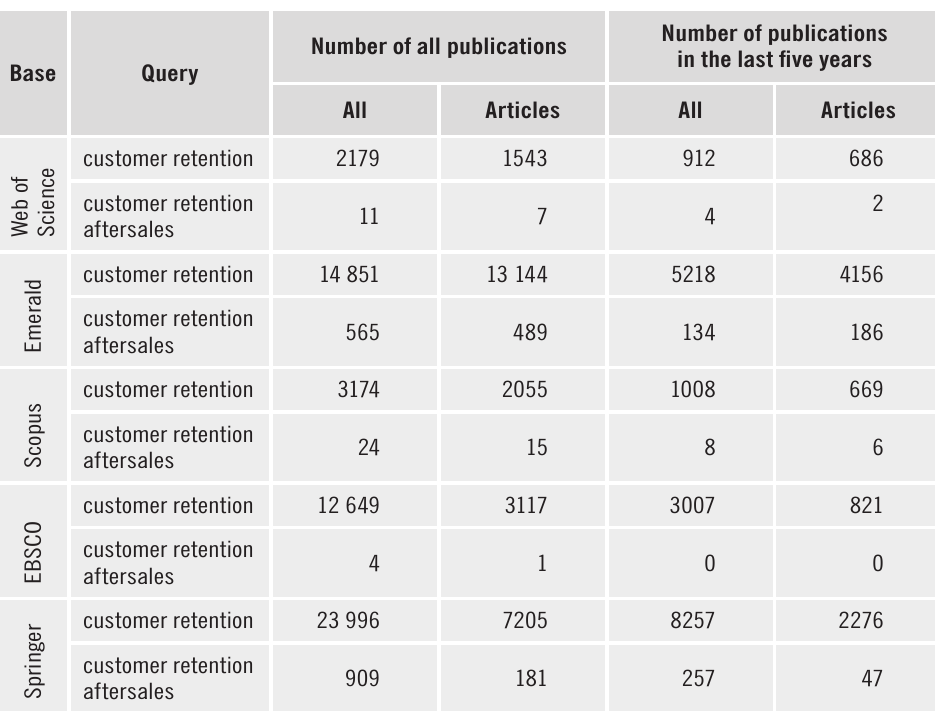
Table 1. Quantitative bibliometric